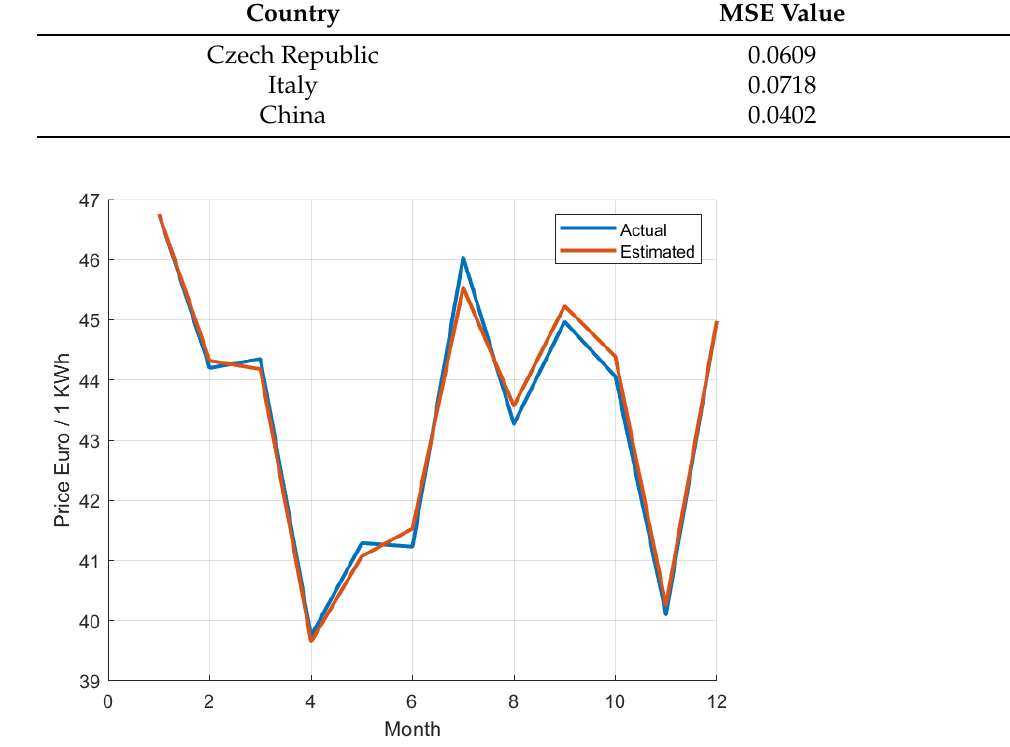
Figure 8. A comparison of estimated EP and the actual EP values in the Czech Republic.